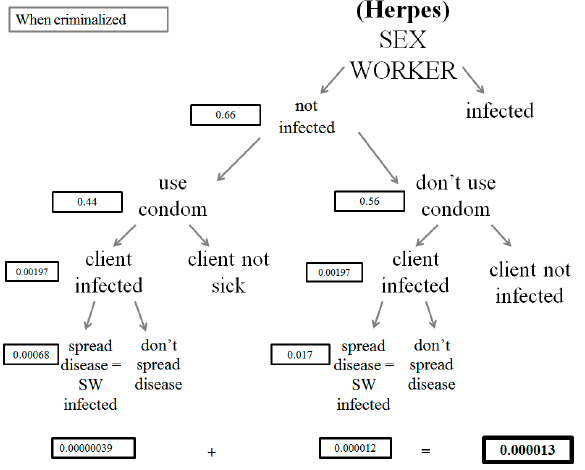
Figure A9. Risk of gonorrhea transmission to a sex worker under decriminalization.